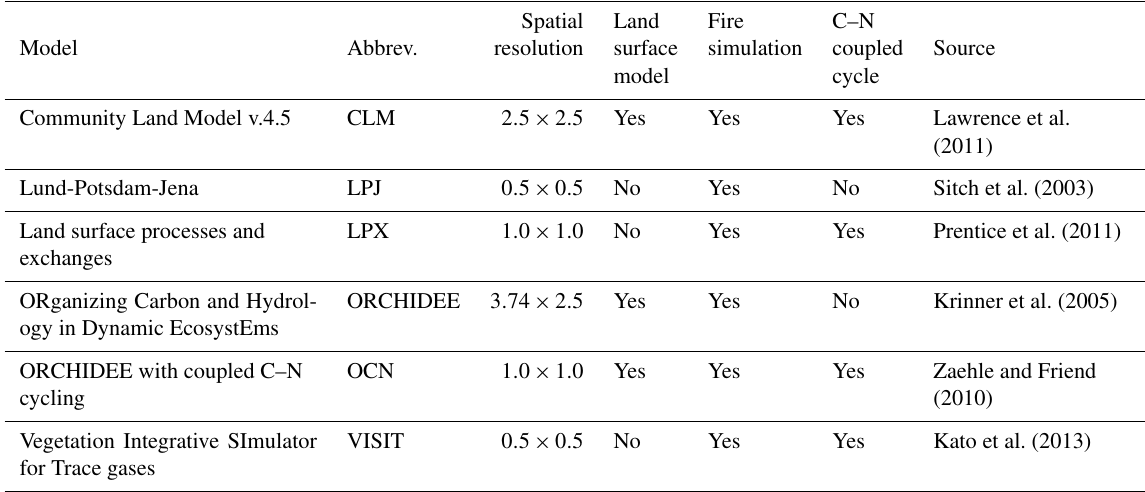
Table 1. Terrestrial ecosystem models from the TRENDY v.2 model intercomparison used to simulate terrestrial net ecosystem exchange. All models simulate carbon (C) cycles, whereas some models also include nitrogen (N) cycles, identified as C–N coupled models. Spatial Land Fire Model Abbrev. resolution surface Community Land Model